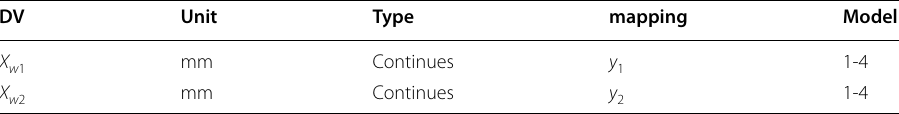
Table 5 Decision variables { D } shear web geometric design